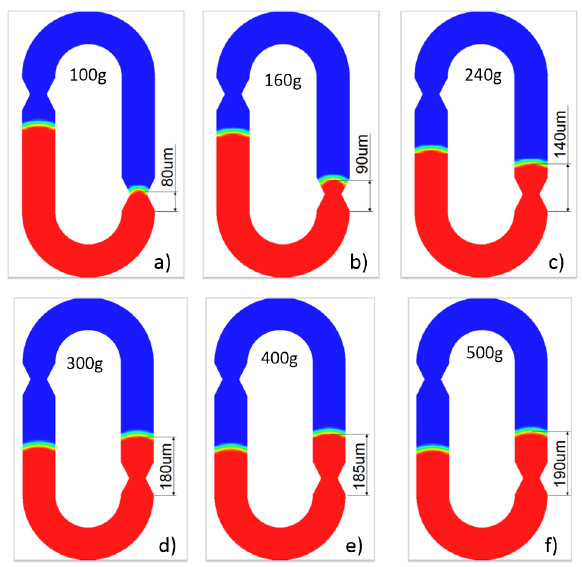
Figure 3. The distribution map. ( a ) under load of 100 g; ( b ) under load of 160 g; ( c ) under load of 240 g; ( d ) under load of 300 g; ( e ) under load of 400 g; ( f ) under load of 500 g.